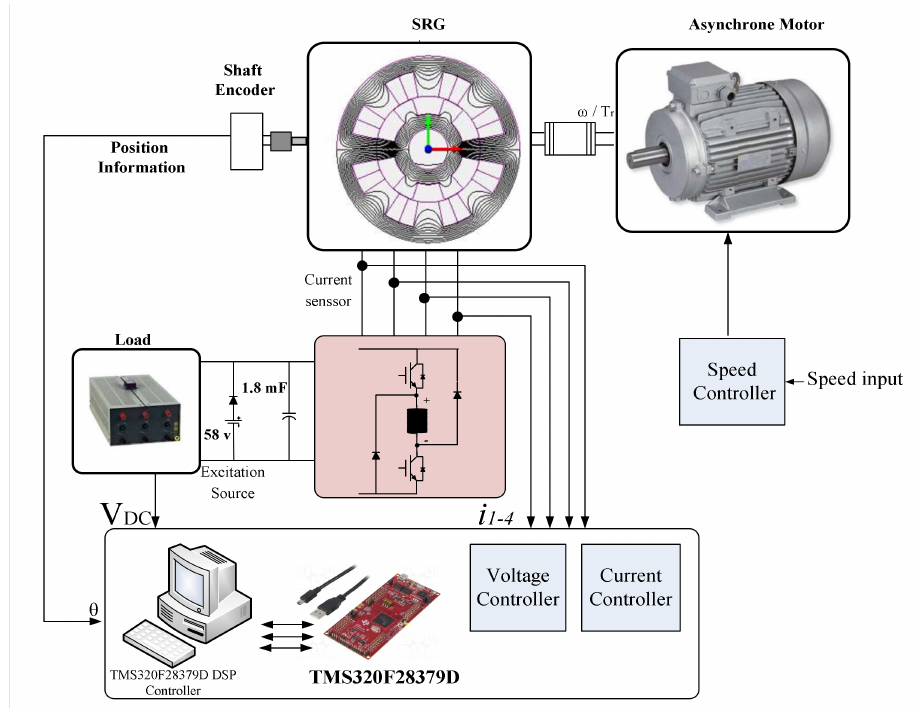
Figure 10. Experimental test